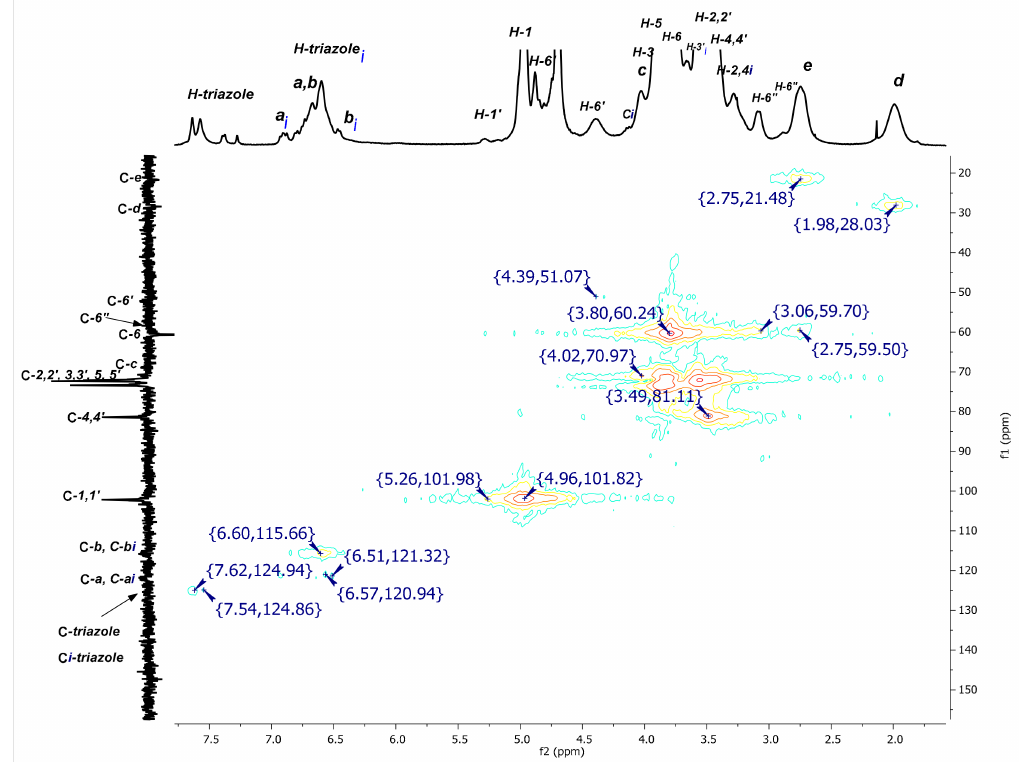
Figure 5. 2D NMR HMQC spectrum of P 3 N 3 -[O-C 6 H 4 -O-(CH 2 ) 3 - β CD] 6 ( I ) in D 2